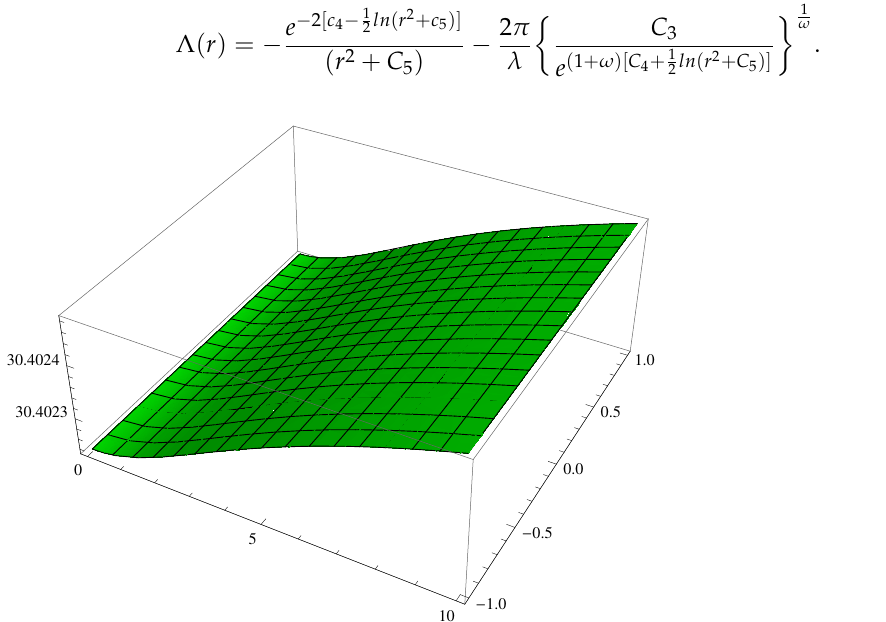
Figure 15. The behaviour of the cosmological constant in presence of dark energy matter source is plotted against r with the values of the arbitrary constants λ = − 0.1, C 3 = 2, C 4 = 0.001, C 5 = 10. Case (iii) : Let Λ (cid:54) = 0, ω (cid:54) = − 1. We